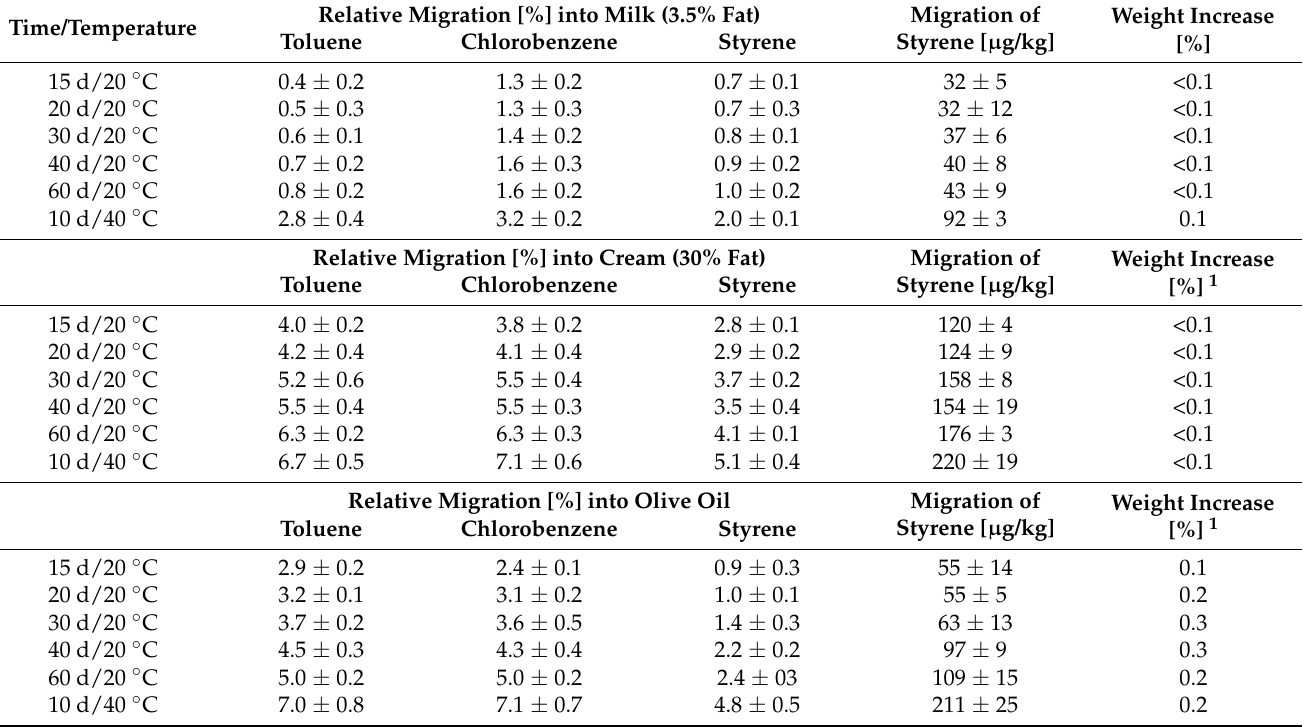
Table 2. Relative migration [%] of volatiles, migrated amount of styrene in real foods ( ± standard deviation of triplicate analysis) and weight increase [%] of the polymer at the tested time/temperature conditions from